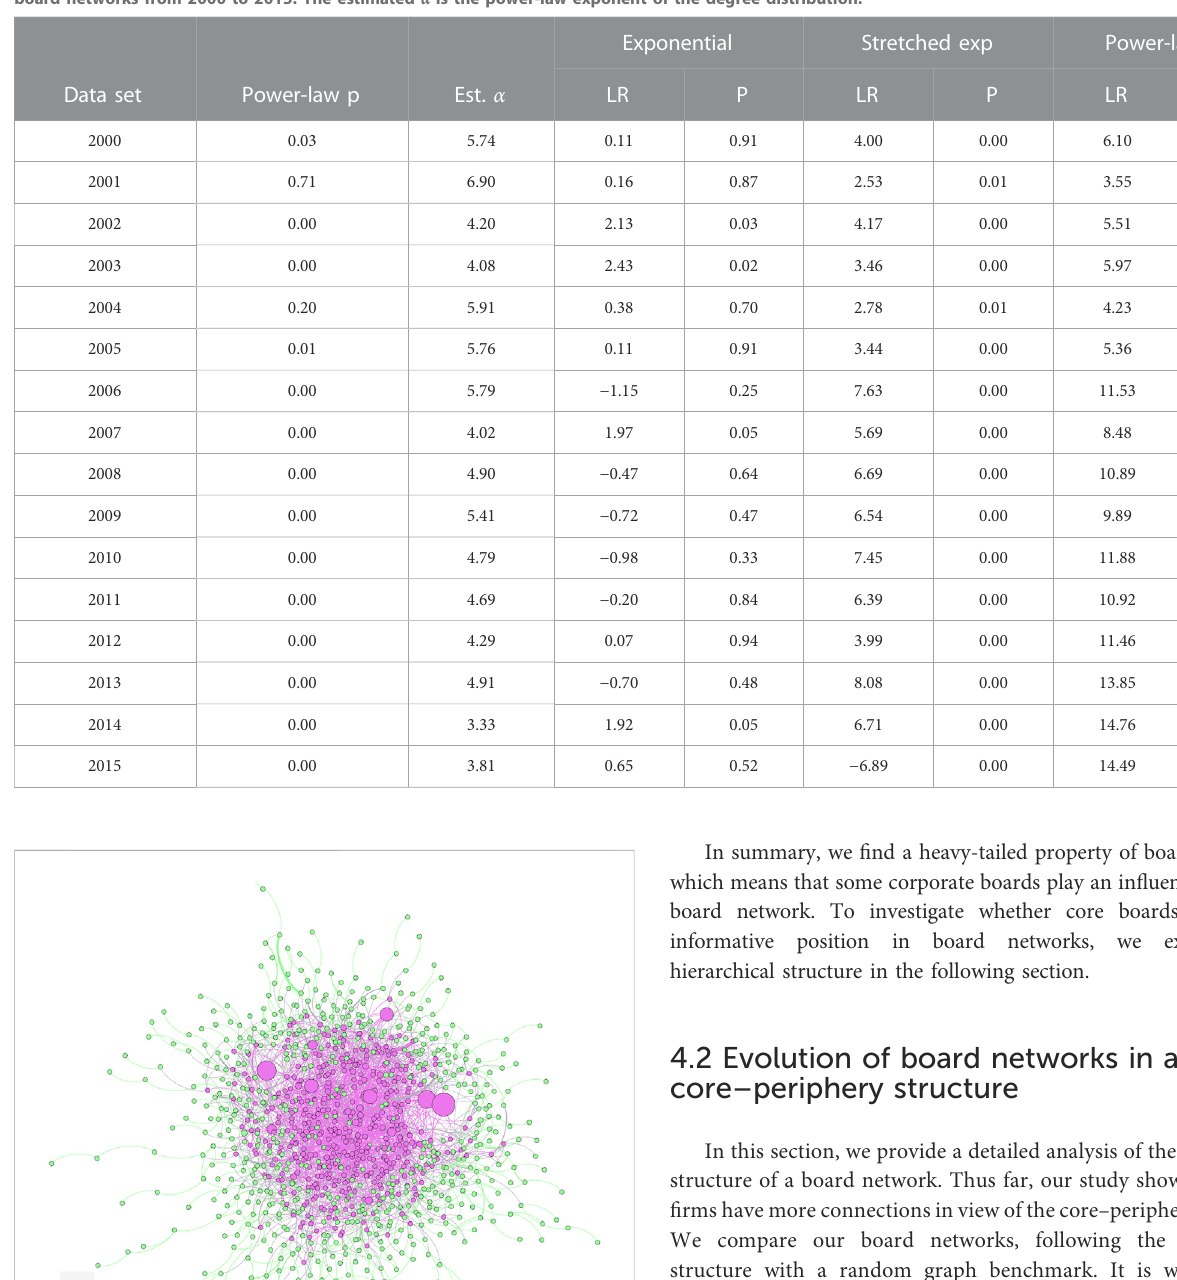
TABLE6Comparisonsofthe fi ttedpower-lawbehaviortoalternatives.Thistableshowstheresultsofthepower-lawtestproposedby[44]forthedegreedistributionof board networks from 2000 to 2015. The estimated α is the power-law exponent of the degree distribution.